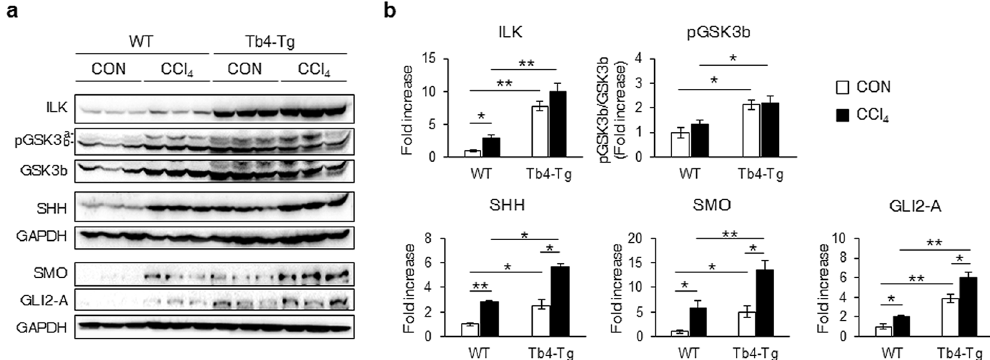
Figure 8. Enhanced expression of Hh, ILK and pGSK3b in livers of Tb4-Tg mice. ( a ) Representative western blot analysis and ( b ) cumulative densitometric analyses of ILK, pGSK3b/GSK3b, SHH, SMO and GLI2-A) in livers from WT and Tb4-Tg mice. (GAPDH was used as an internal control). Immunoblots shown represent one of three experiments with similar results. Results of relative expression are shown as mean ± s.e.m. ( * p < 0.05; ** p <